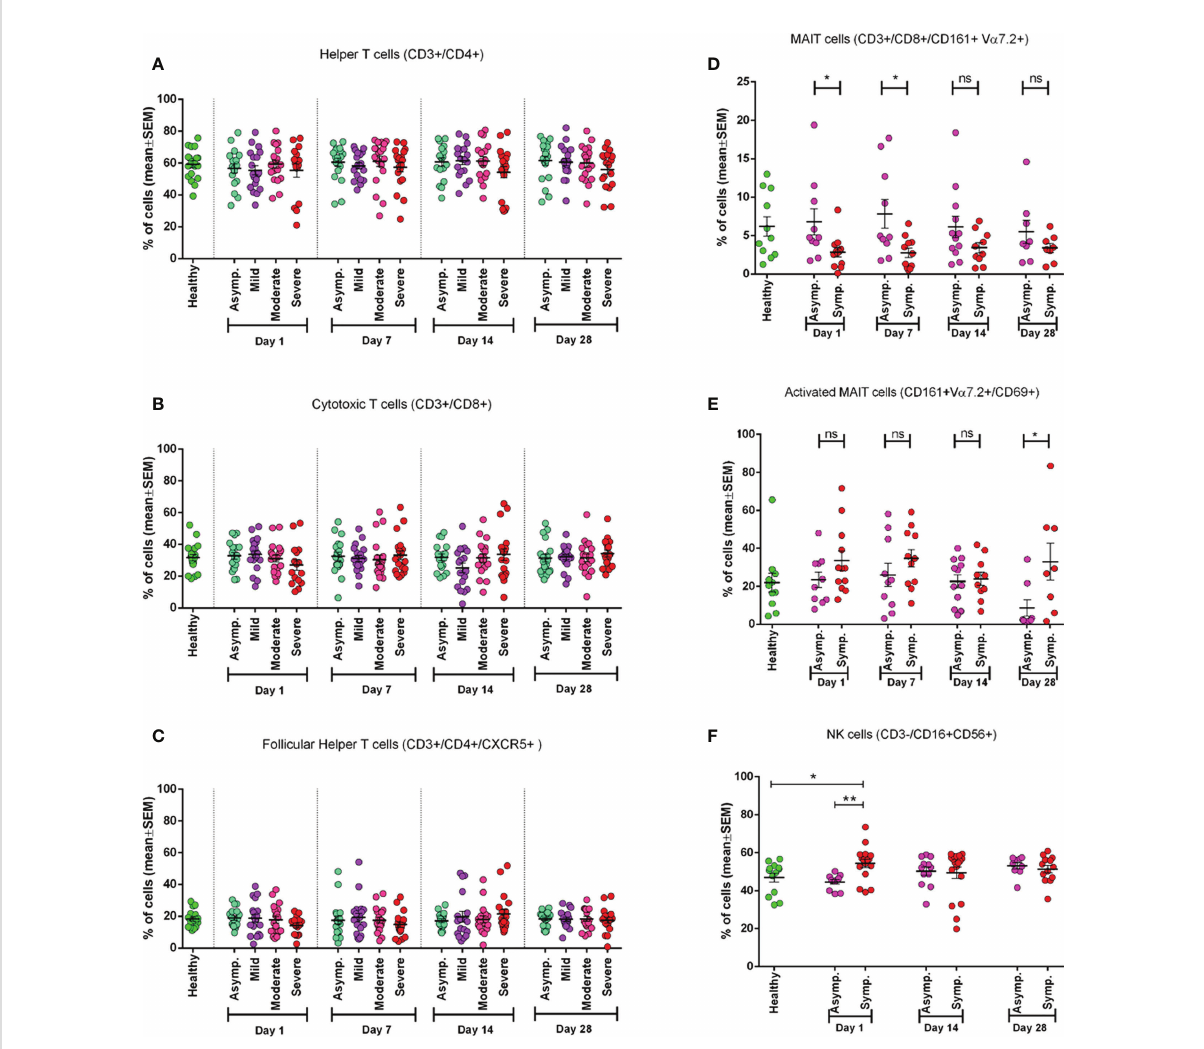
FIGURE 1 Frequency of different immune cell types in different categories of COVID-19 patients (asymptomatic (n=18), mild (n=19), moderate (n=19), and severe (n=16)) at different day points from the onset of infection and compared with the Healthy controls (n=19). (A) Percentage of Helper T cells in CD3+ cells, (B) percentage of Cytotoxic T cells in CD3+ cells, (C) percentage of Follicular Helper T cells in CD4+ cells. In plots (D-E) symptomatic and asymptomatic COVID-19 patients are compared for (D) MAIT cells as a percentage of CD8+ cells, (E) CD69+ activated MAIT cells (healthy (n=11), asymptomatic (n=10), symptomatic (n=12) patients). (F) Percentage of Natural Killer (NK) cells (healthy (n=13), asymptomatic (n=11), symptomatic (n=16) patients). Bars represent the mean value with the Standard Error of Mean. Statistical comparisons were done (D-F) using a two-tail Mann-Whitney test. *p <0.05; **p <0.01; ns, non-signi fi